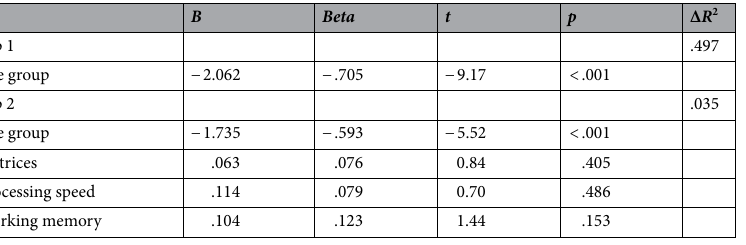
Table 4. Regression predicting emotion Morph balanced integration score (speed + accuracy). Δ R 2 represents the additional variance accounted for by all the variables in a step. Regression statistics given with relevant variables at a step in the prediction equation (i.e., Age Group at Step 1, and all four variables at Step 2). Age group was treated as a dichotomous variable (young vs. older adults) in the regression.